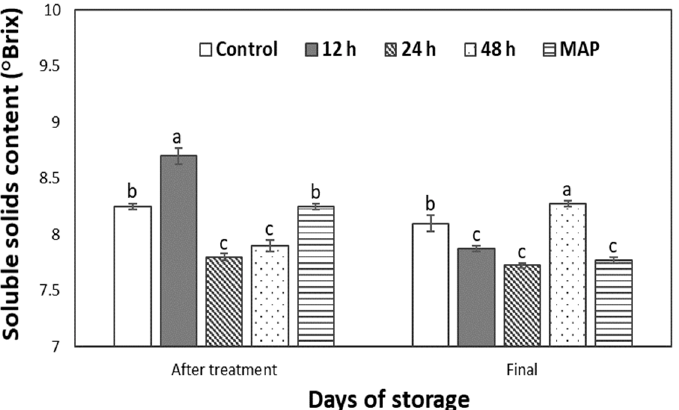
Figure 6. Soluble solids content of sweet peppers pretreated with 10% CO 2 for 12, 24, and 48 h, as well as untreated and modified atmosphere packaging (MAP) with 50,000 cc · m − 2 · day − 1 · atm − 1 OTR film after treatment and the last day of storage. The vertical bars represent ± SE of n = 4 and different letters indicate a significant difference at p ˂ 0.05.